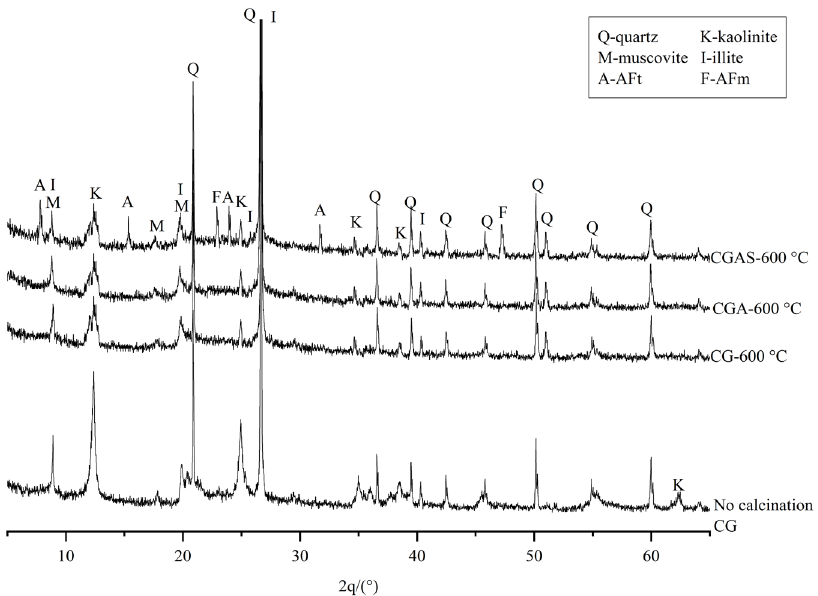
Figure 8. XRD of coal gangue with different treatment methods.